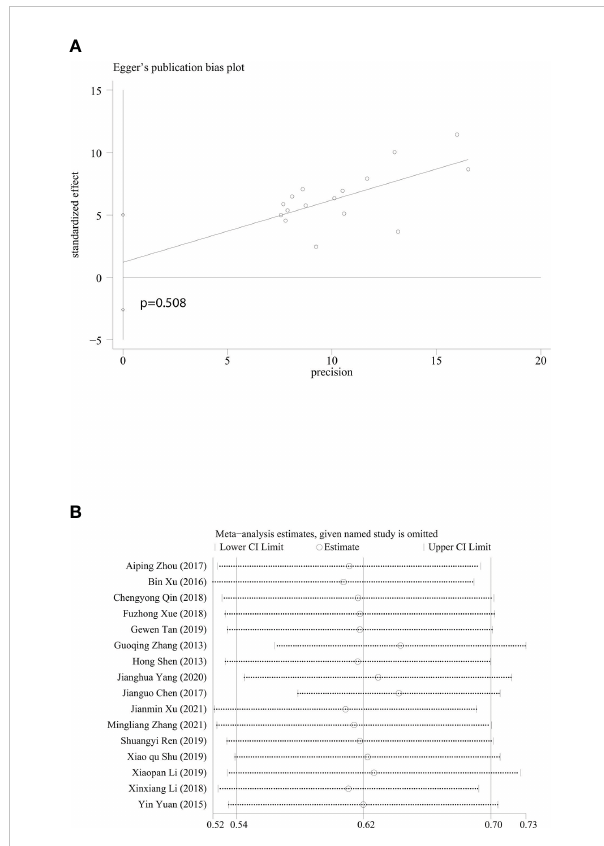
FIGURE 5 Egger ’ s publication bias plot and sensitivity analysis. (A) Egger ’ s publication bias plot based on 5-year survival rate. (B) Sensitivity analysis based on 5-year survival rate. Every horizontal line representing combined 5-year survival and the range of 95% CI after omitting study of the included studies one by